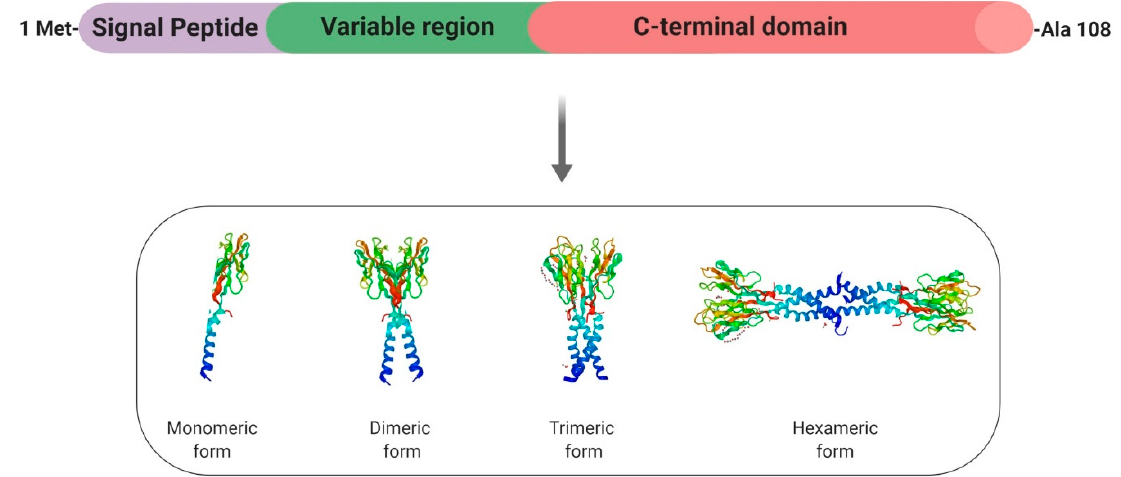
Figure 3. Structure and specific forms of human resistin. Human resistin is composed by a signal peptide (purple), a variable region (green) and a C-terminal domain. Resistin can be found under the monomeric form and can form dimeric and trimeric proteins thanks to disulfide bridges. Then, disulfide and non-disulfide bridges can be involved in the formation of the hexameric protein.